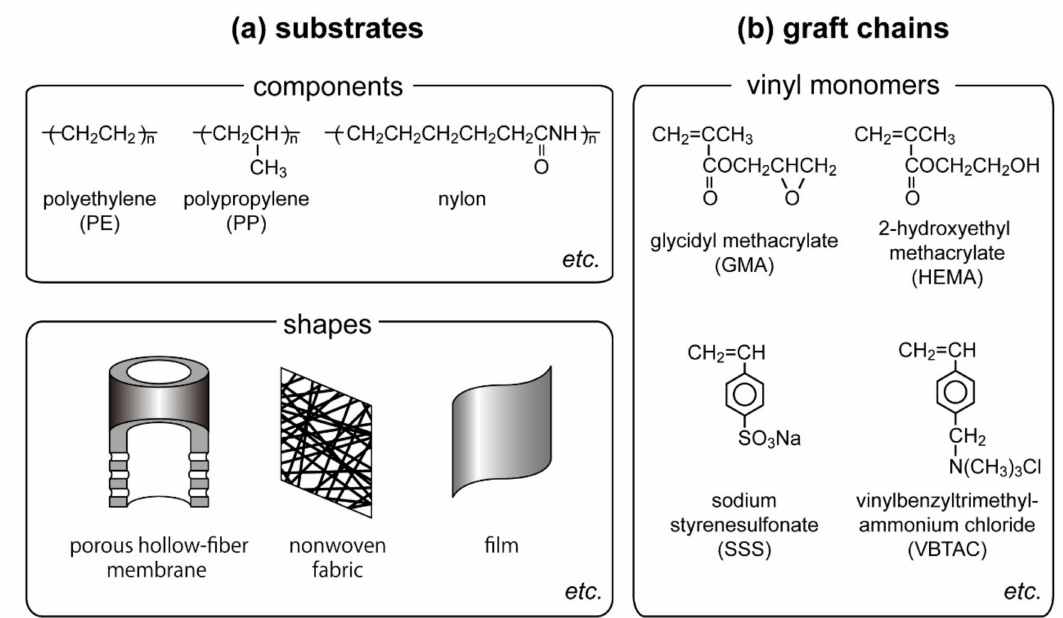
Figure 3. Constituents for the preparation of functional materials by utilizing radiation-induced graft polymerization. ( a ) Utilizable components and shapes as substrates, ( b ) vinyl monomers for graft